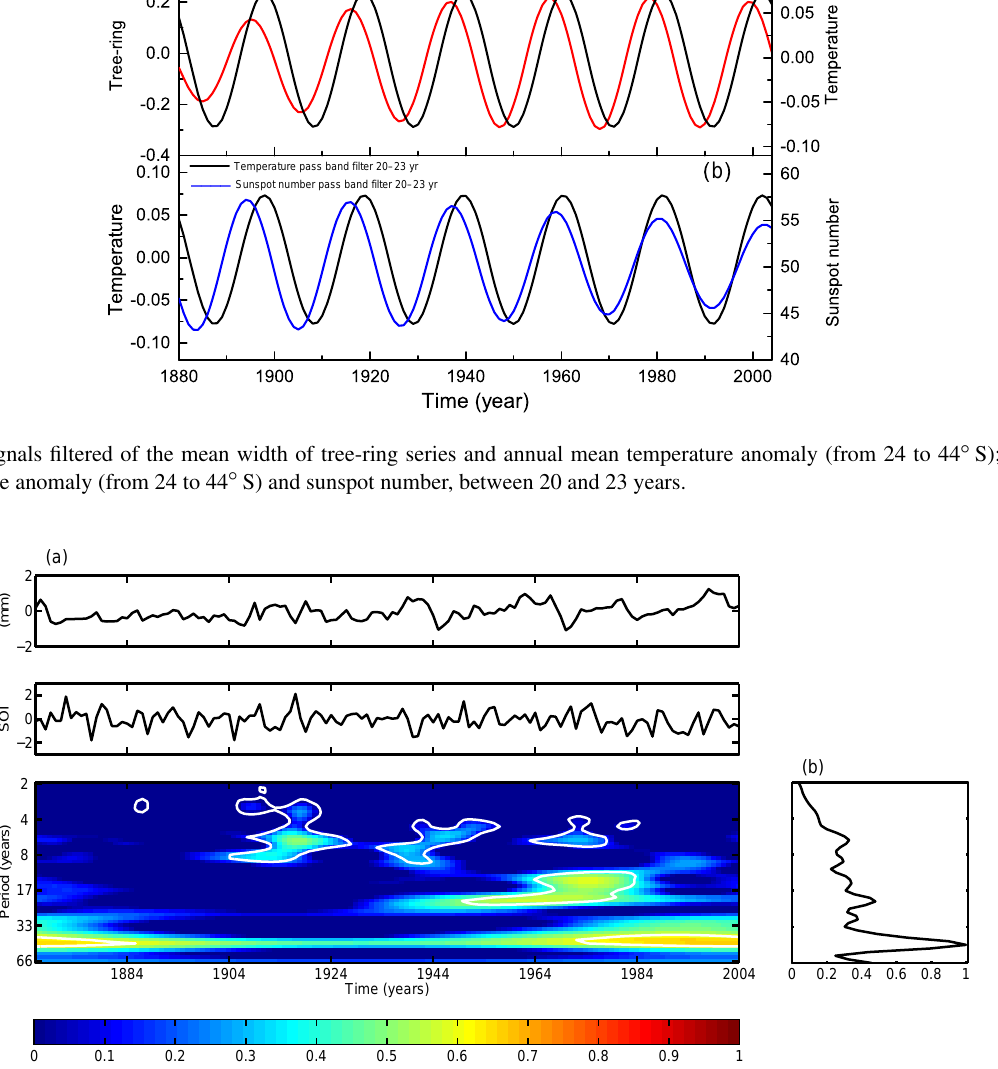
Figure 8. Morlet cross-wavelet map between tree-ring average chronology collected in Passo Fundo and the SOI. The contour plot represents the significance levels for 95%. Panel (b) presents the global wavelet spectrum, which is defined as the wavelet coefficients power average for each scale, i.e., it corresponds to a Fourier